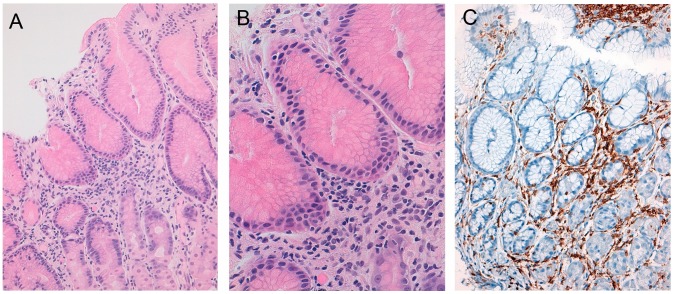
Representative photomicrograph of a gastric biopsy (Case 3).A mild lymphocytic infiltrate is present (A) with “rimming” of gastric glands (B). The lymphocytes express CD4 (C).